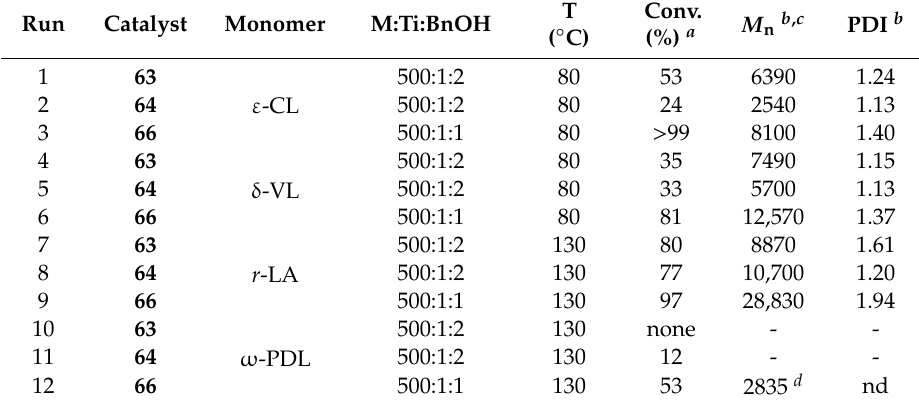
Table 23. Comparison between the activities of various Ti-based ROP catalysts